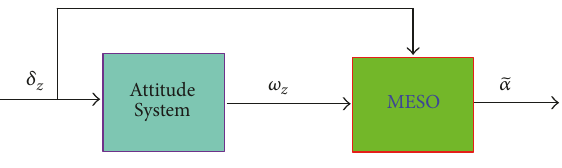
Figure 2: The structure of AOA